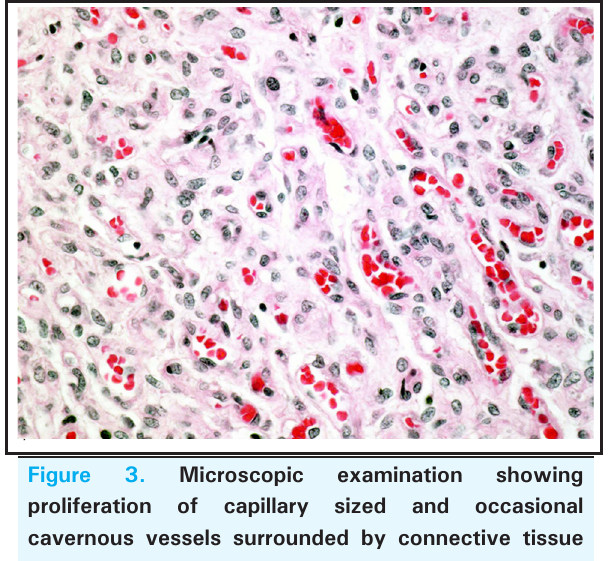
Figure 3. Microscopic examination showing proliferation of capillary sized and occasional cavernous vessels surrounded by connective tissue